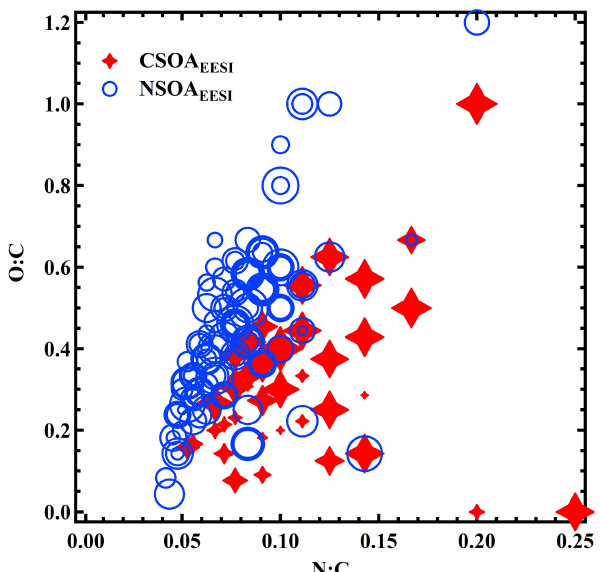
Figure 15. The atomic O : C vs. N : C plot of the CS-OA EESI and NSOA EESI factors’ mass spectra. Points are sized by the H : C value of each distinguished ion of CS-OA EESI and NSOA EESI